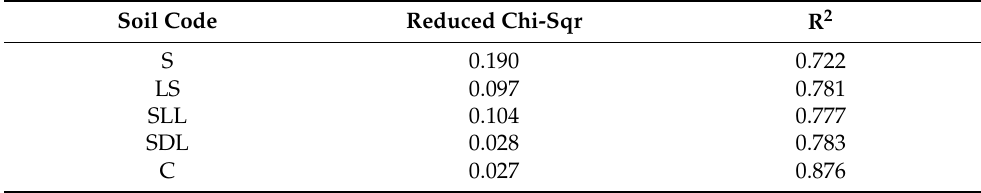
Table 3. Reduced Chi-Sqr and R 2 of the measured value and the Campbell model simulation value for soils with different